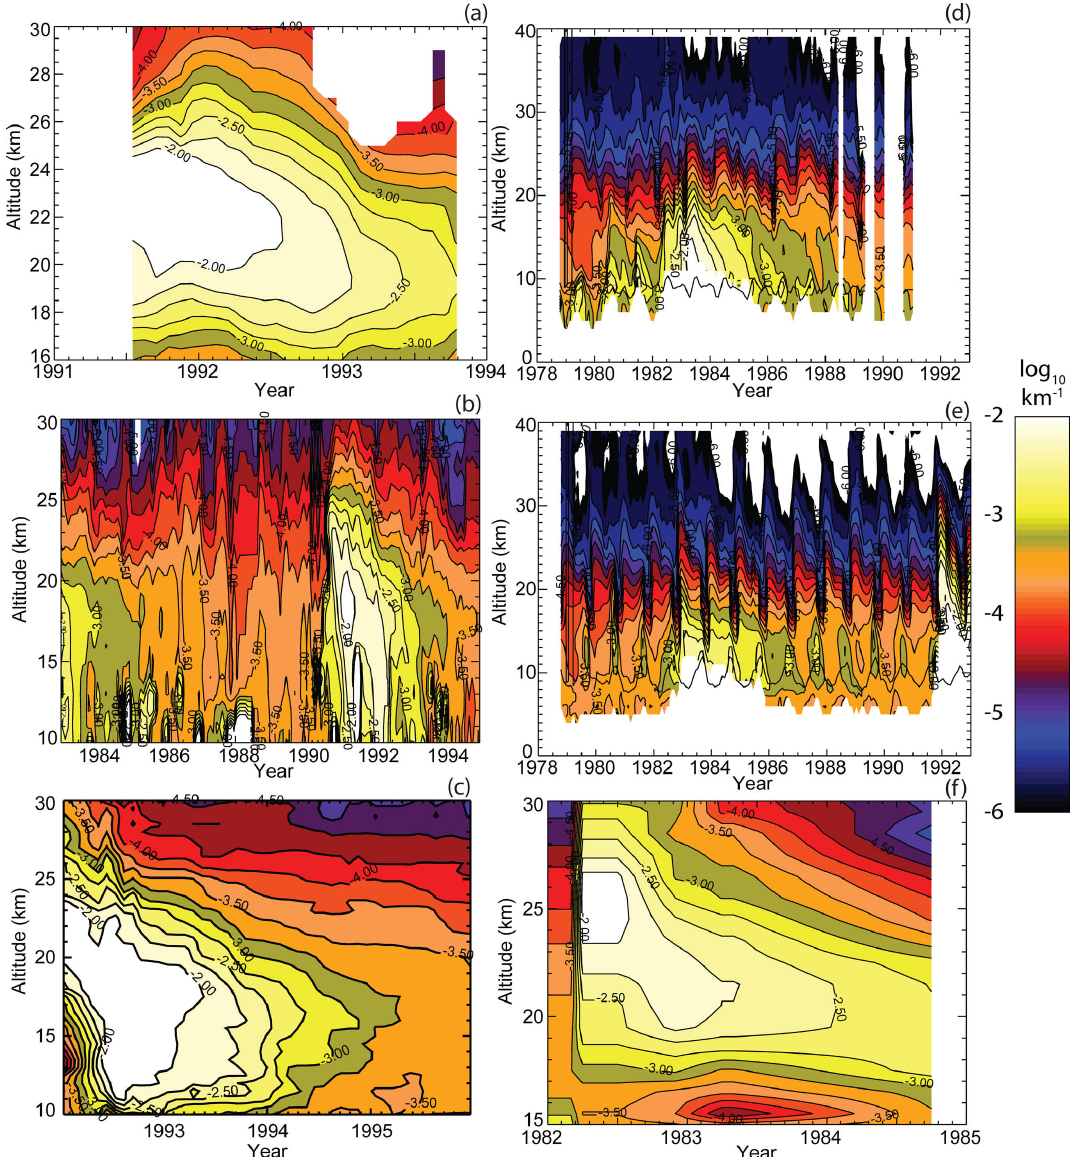
Figure 9. Component contributors to GloSSAC or previous versions all shown in aerosol extinction coefficient at 1020nm. They include: (a) the ASAP-based Camaguey–Mauna Loa “tropical” construction, (b) NASA LaRC 48-inch lidar record, (c) NIWA Lauder backscat- ter sonde Pinatubo record, (d) SAM II Southern Hemisphere, (e) SAM II Northern Hemisphere, and (f) the ASAP-derived airborne li- dar/SAGE/SAGE II tropical reconstruction for 1982 to